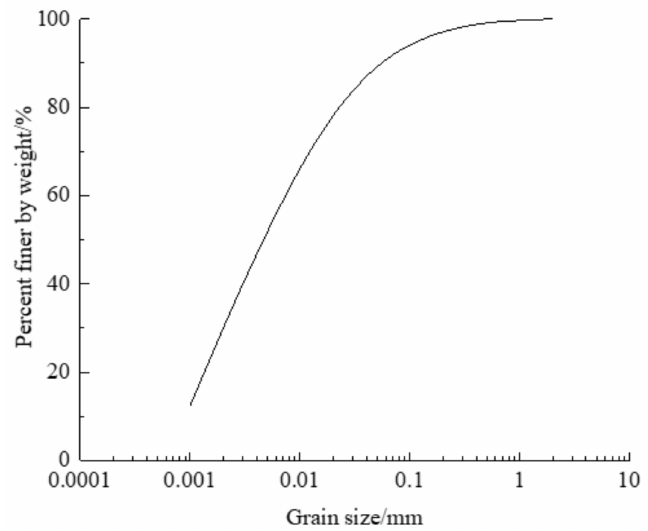
Figure 2. Gradation curve for the test